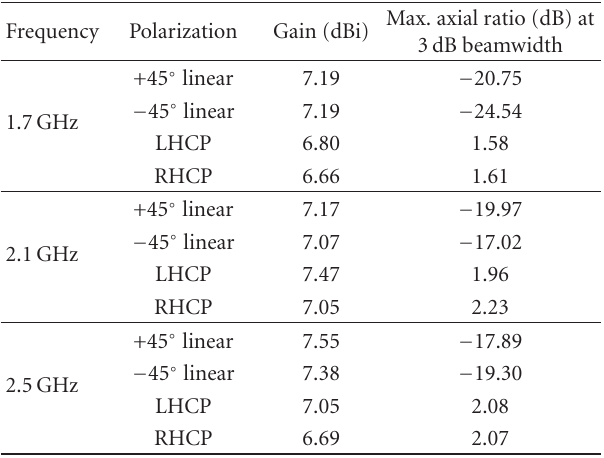
Table 2: Gain and axial ratio performances of BPCDE